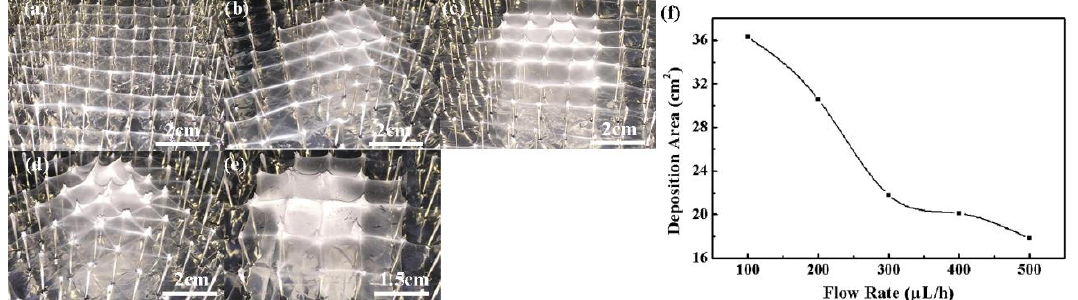
Figure 8. Effect of flow rates on the printed 3D nanofibrous structures. ( a ) 100 μL/ h; ( b ) 200 μL/ h; ( c ) 300 μL/ h; ( d ) 400 μL/ h; ( e ) 500 μL/ h; ( f ) relationship between deposition area and flow rate. The probe height, probe interval, and applied voltage were 20 mm, 10 mm, and 25 kV, respectively.